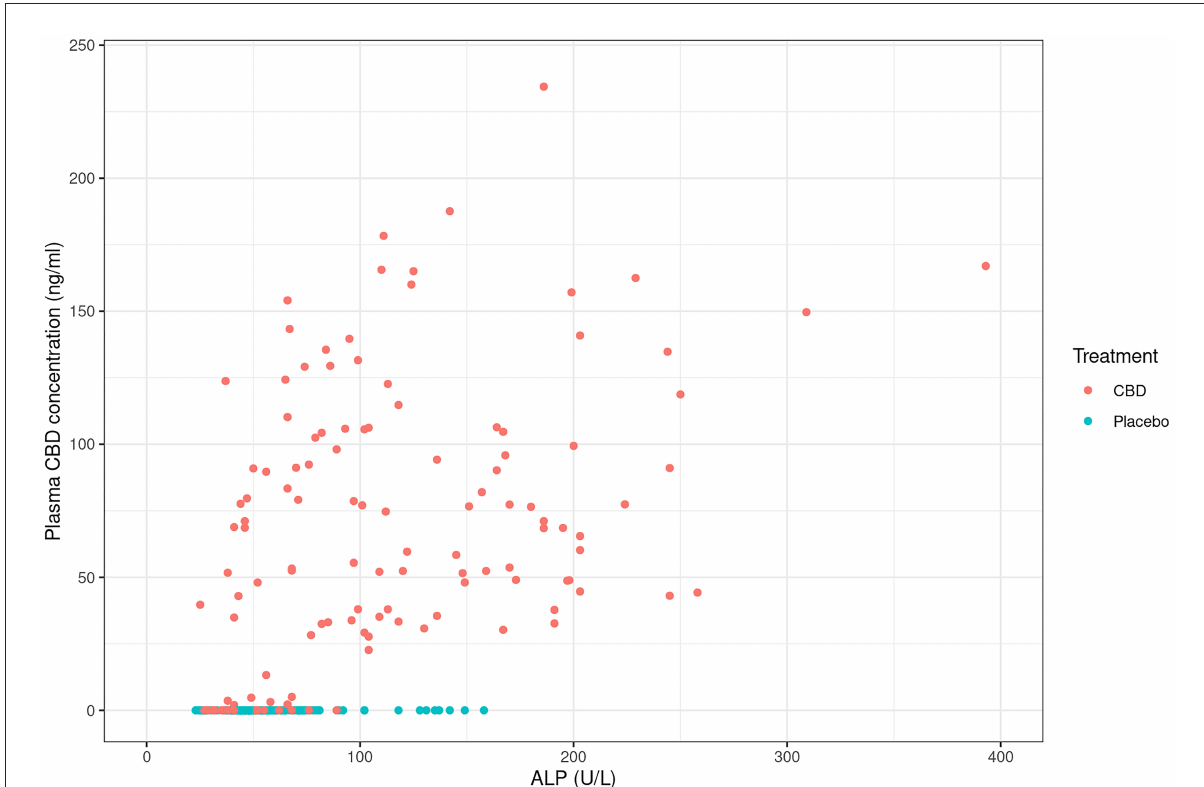
FIGURE8 Scatter plot to depict a weak positive correlation between plasma CBD concentration (ng/ml) and alkaline phosphatase (ALP; U/L) in CBD-dosed dogs when all time points are combined ( r =